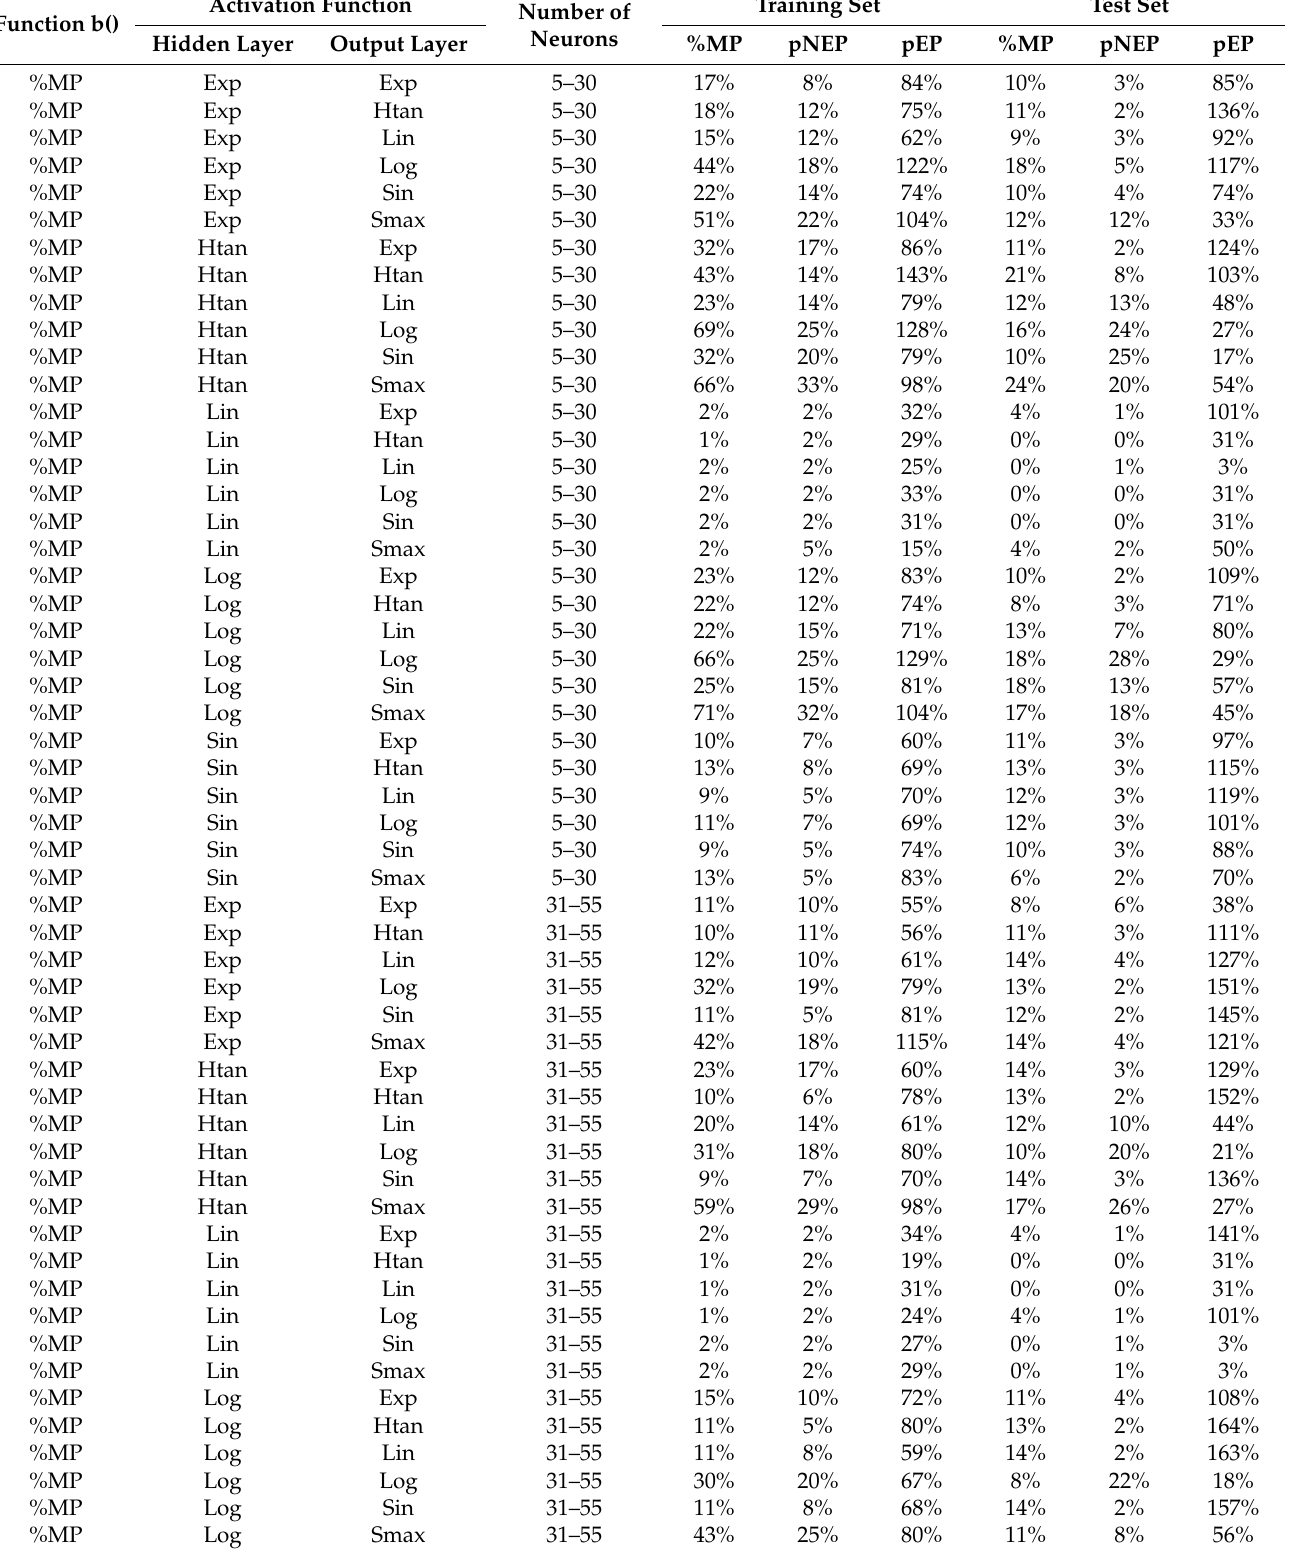
Table A1. The best results for the %MP and pNEP